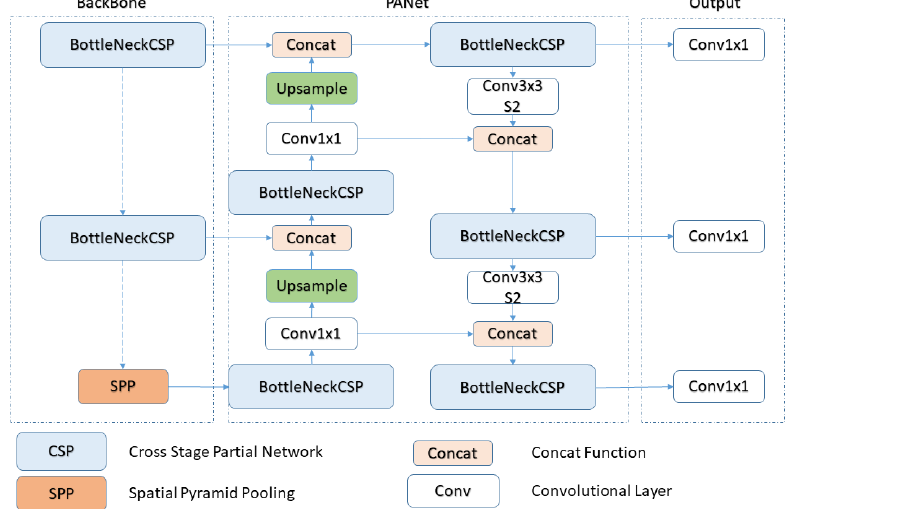
Figure 6. YOLOv5 Network Architecture: It consists of three stages: In the first stage, data is fed into the backbone which extracts the features, then it passes through the neck in the second stage, where the features are fused, and the third stage, named head, outputs the detection results